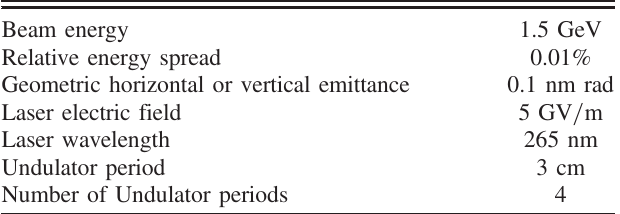
TABLE I. The nominal parameters of electron beam, laser and